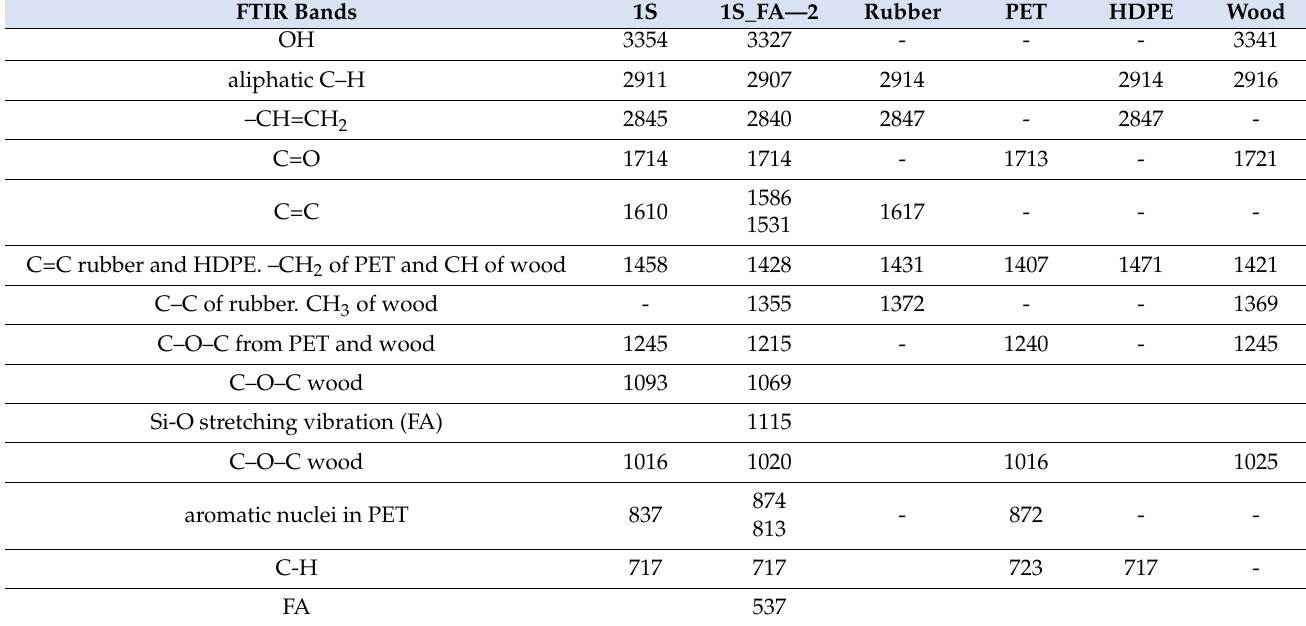
Table 4. FTIR bands of the composites with and with no FA